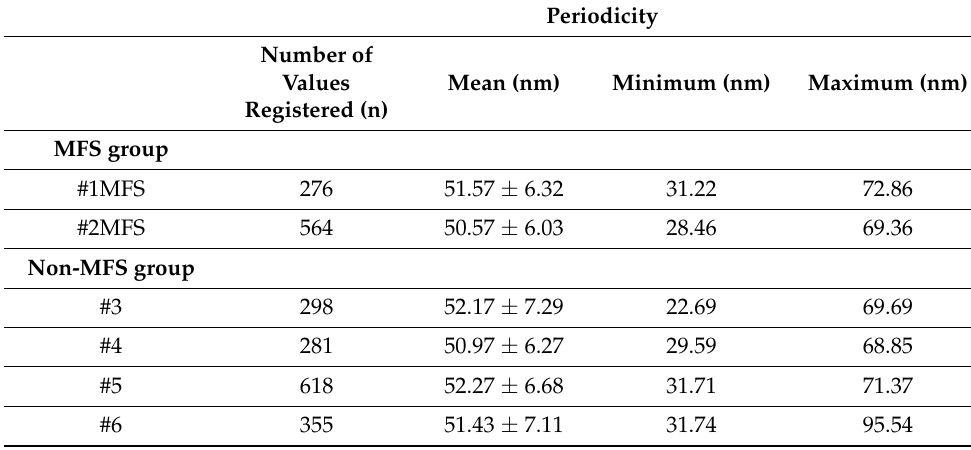
Table 2. Summary of the fibrillin microfibril periodicity results both per group and per individual